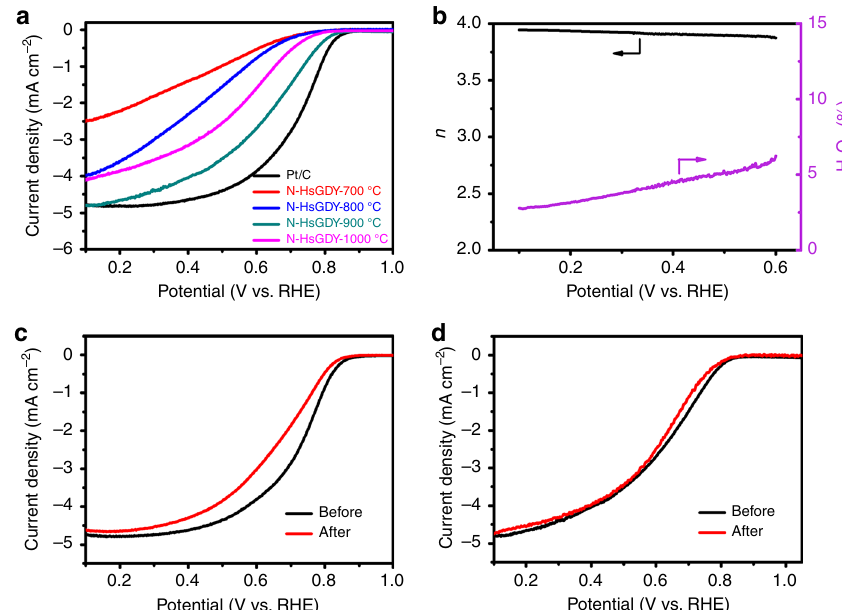
Fig. 6 Performance of catalysts for the oxygen reduction reaction in acidic media. a Linear sweep voltammetry curves of commercial Pt/C and all of the pyridinic nitrogen-doped hydrogen-substituted graphdiyne (N-HsGDY) catalysts recorded in O 2 -saturated 0.1 M HClO 4 at 1600 rpm. b Electron transfer number and peroxide yield calculated from the rotating ring-disk electrode (RRDE) measurements for N-HsGDY treated at 900 °C (N-HsGDY-900 °C). c , d Durability tests of the commercial carbon-based platinum catalyst (Pt/C) ( c ), and N-HsGDY-900 °C ( d ) catalysts before and after 5000 cycles in O 2 - saturated 0.1 M HClO